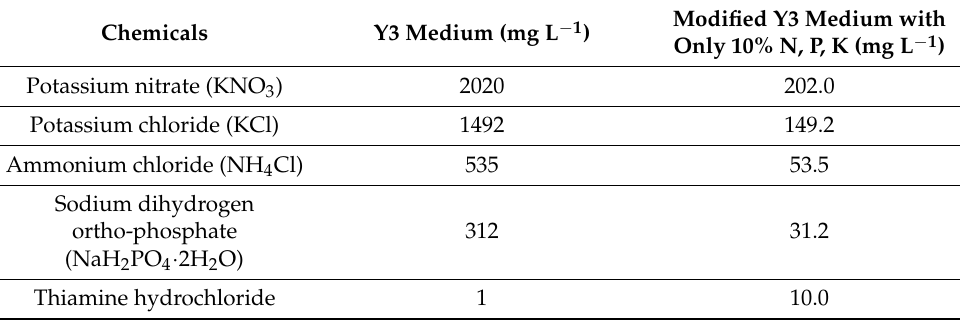
Table 7. The differences in the make-up of the standard and modified Y3